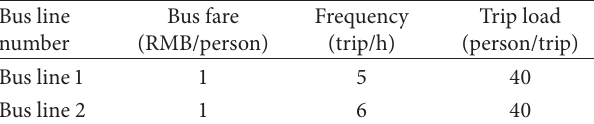
Table 3: Operative information of bus